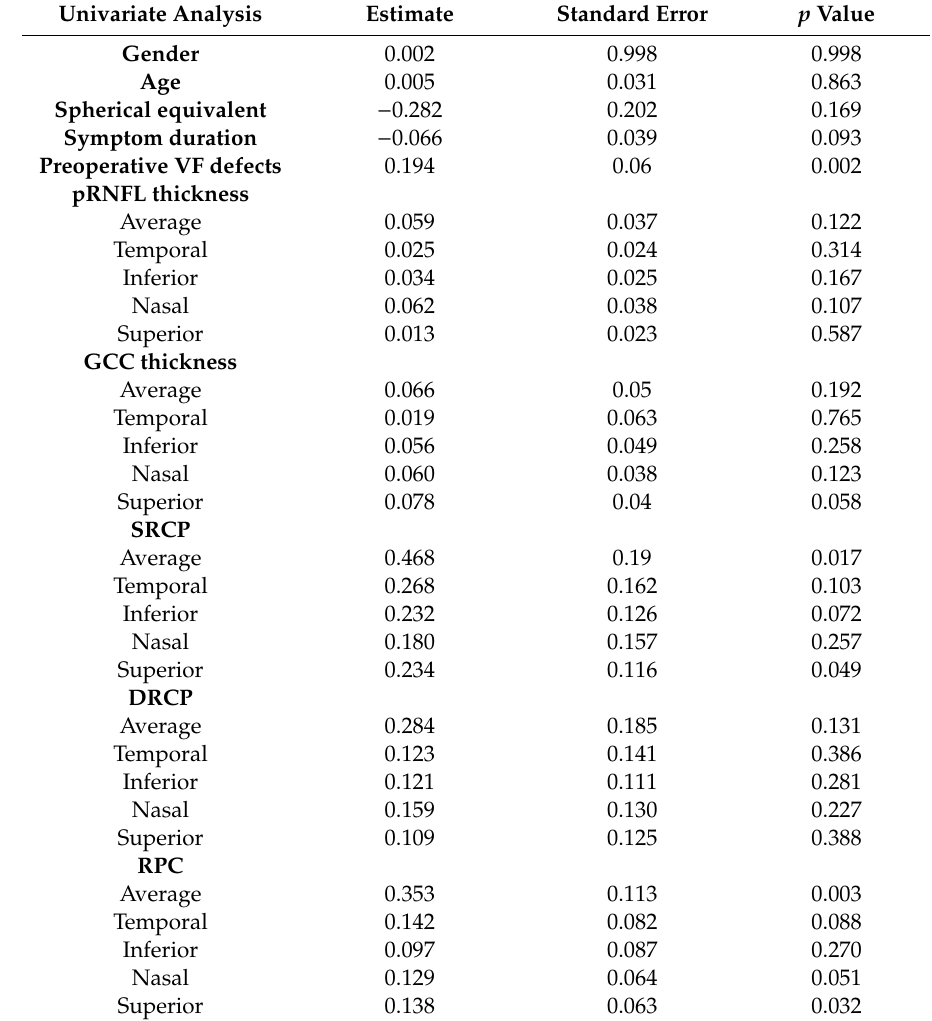
Table3. Associationbetweenpostoperativevisualfielddefectsanddemographicfactorsandophthalmic parameters: univariate